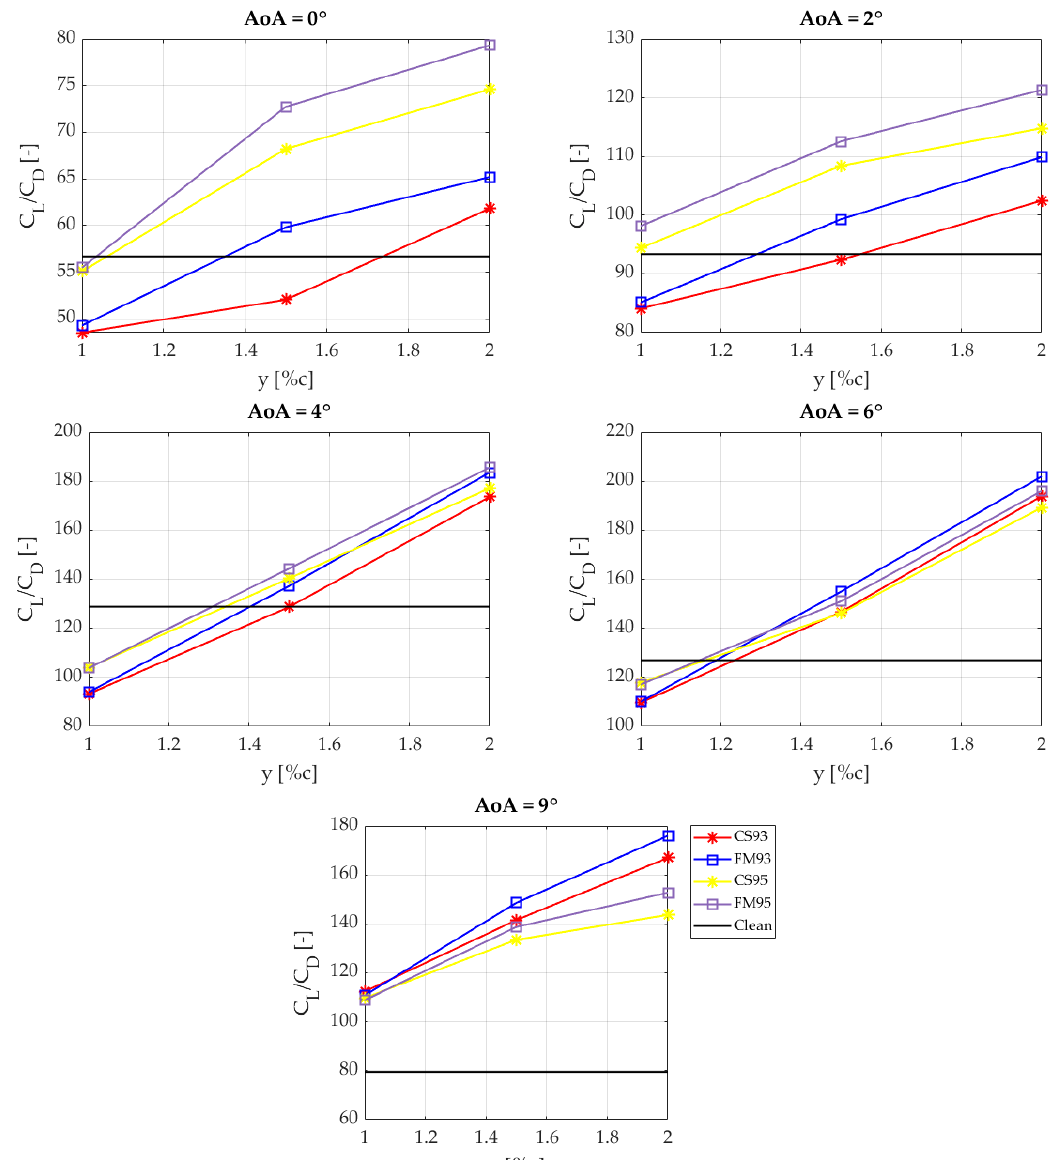
Figure 6. MT configuration cases. Each plot shows the effects of MT length variation on the C L /C D lift-to-drag ratio. A single AoA per plot is represented. AoAs range between 0 and 9°. Figure 6 represents the error of the cell-set model by taking as a reference the fully mesh one.